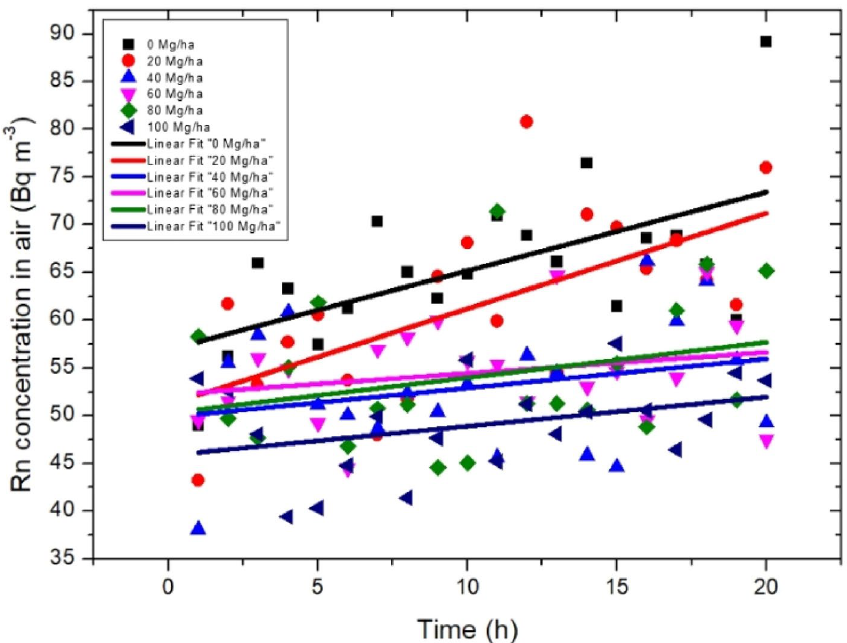
Figure 5. Radon concentration in air measured for five soil samples collected in the experimental fields and for the control sample (0 Mg ha −1 ) as a function of the measurement time. Symbols represent measurements results from the AlphaGUARD instrument, and the lines represent the linear fits. The biochar dose applied into the soil ranged from 20 to 100 Mg ha −1 .